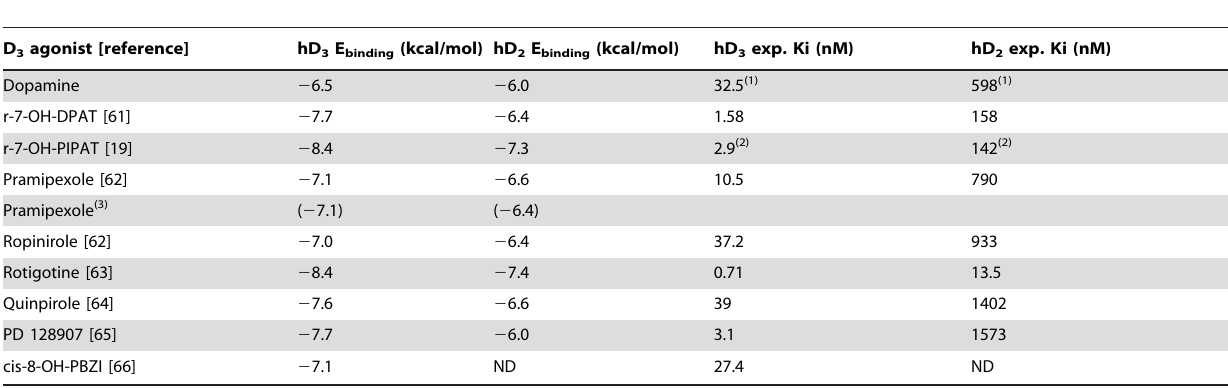
Table 2. Predicted binding energy (Autodock 4.2) of D 3 agonists towards hD 3 and hD 2 receptors. Experimental K i (exp. K i ) with respective references are also shown.